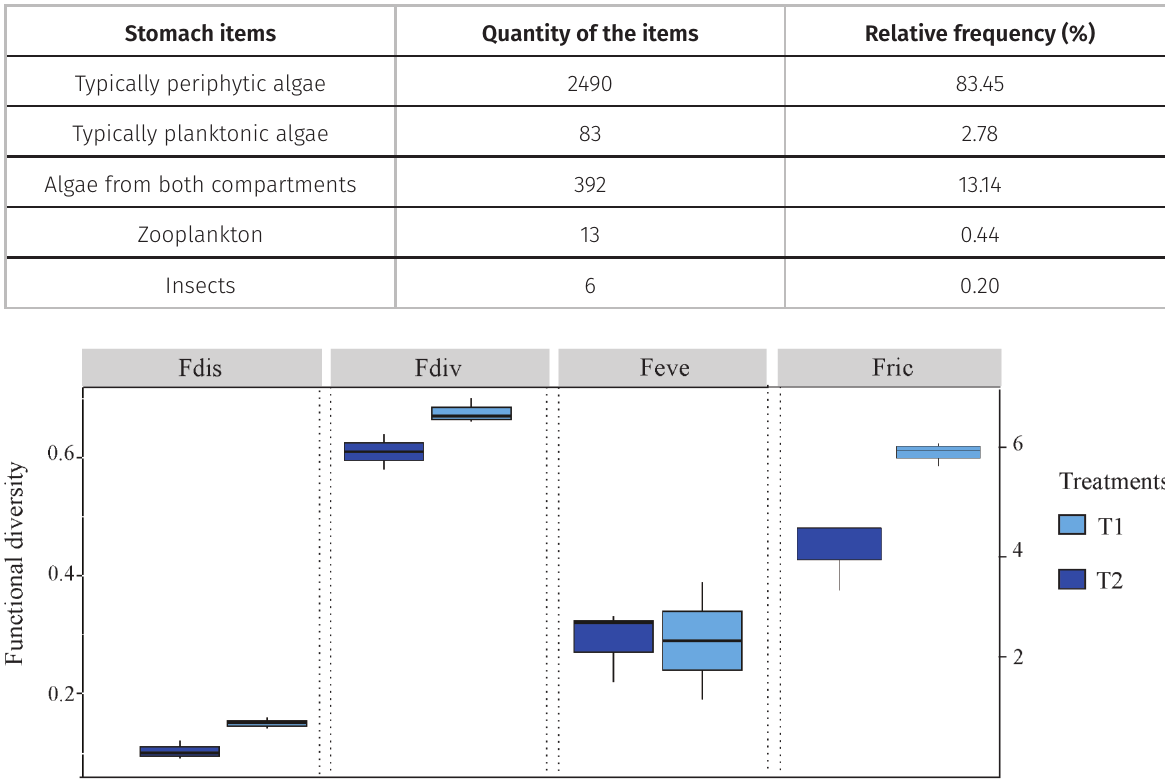
Figure 2. Results of the indices of zooplankton functional diversity between treatments (non-predation - T1 - box of light color and predation by an omnivorous fish - T2 - box of dark color). The indexes of Fdis (functional dispersion), Fdiv (functional divergence), Feve (functional eveness) are represented on the y-left axis of the graph and, Fric (functional richness) on the y-right